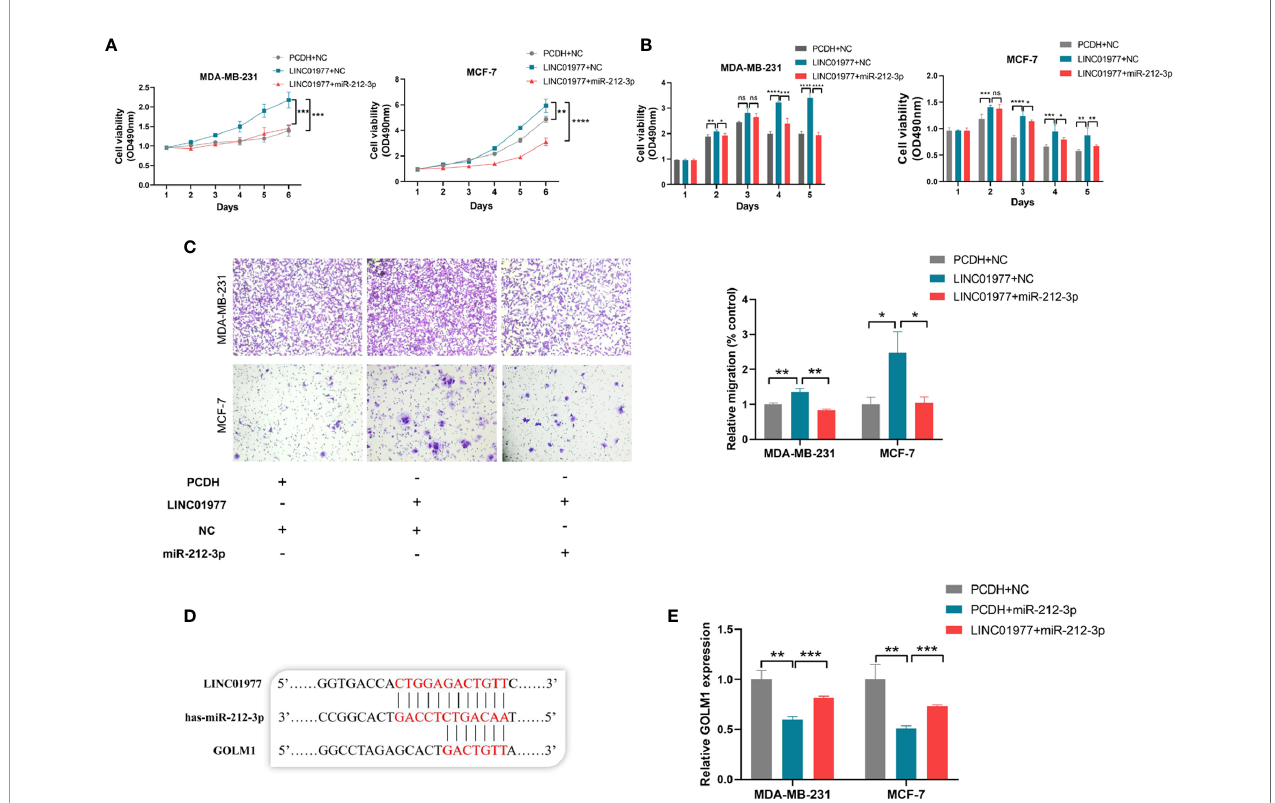
FIGURE 5 | LINC01977 rescued GOLM1 expression via ceRNA mechanism. (A) Promotion of cell proliferation by LINC01977 was rescued by miR-212-3p expression. (B) Promotion of DOX resistance by LINC01977 was rescued by miR-212-3p expression. (C) Promotion of cell migration by LINC01977 was rescued by miR-212-3p expression. (D) The predicted binding site for GOLM1. (E) Real-time PCR was used to identify that GOLM1 expression could be suppressed by miR- 212-3p expression and promoted by LINC01977 expression. (*p < 0.05, **p < 0.01, ***p < 0.001, ****p < 0.0001; Student ’ s